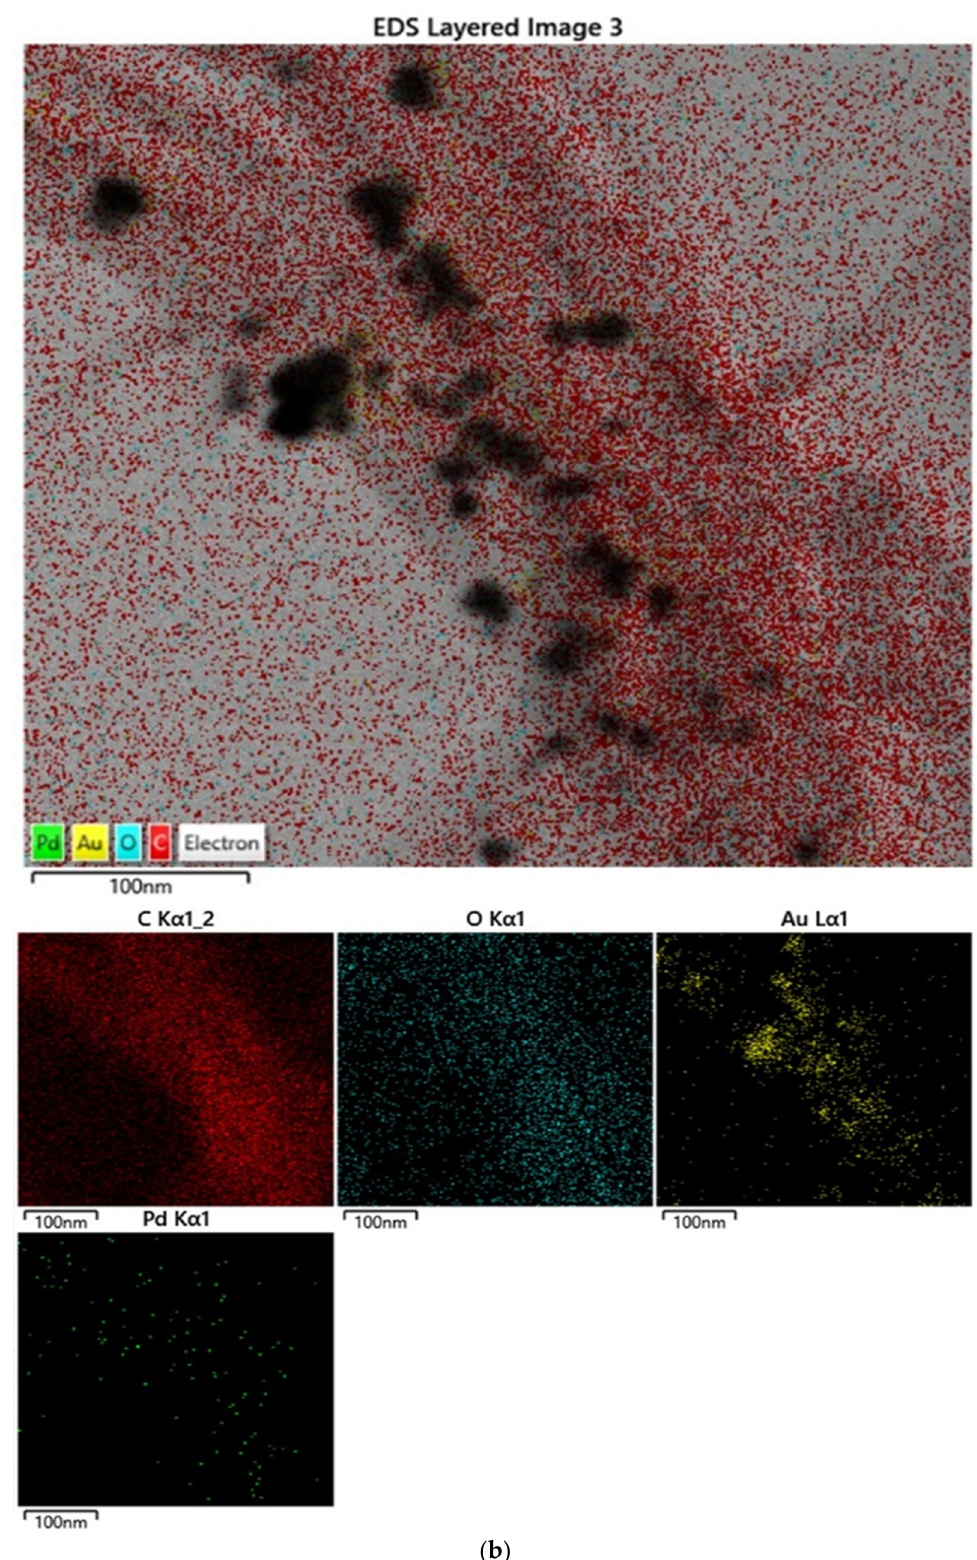
Figure 5. ( a ) Elemental analysis of 1% Pd-5% Au/MWCNT using EDS; ( b ) element mapping patterns of 1% Pd-5% Au/MWCNT.